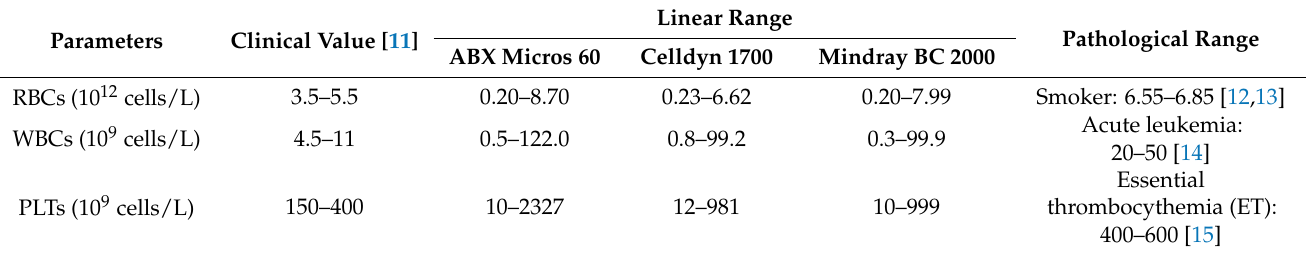
Table 1. High, normal, and low threshold values of three parameters: RBCs, WBCs,